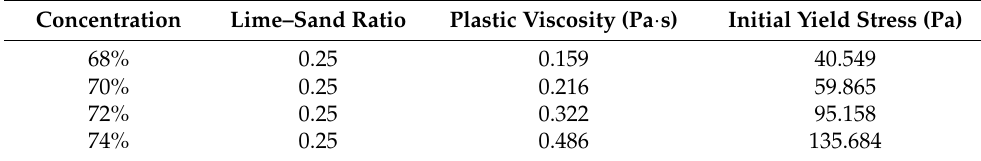
Table 2. Slurry rheological